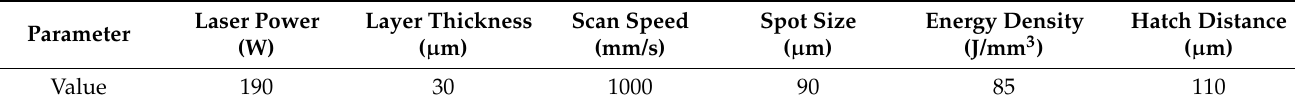
Table 3. Laser parameters used in manufacturing